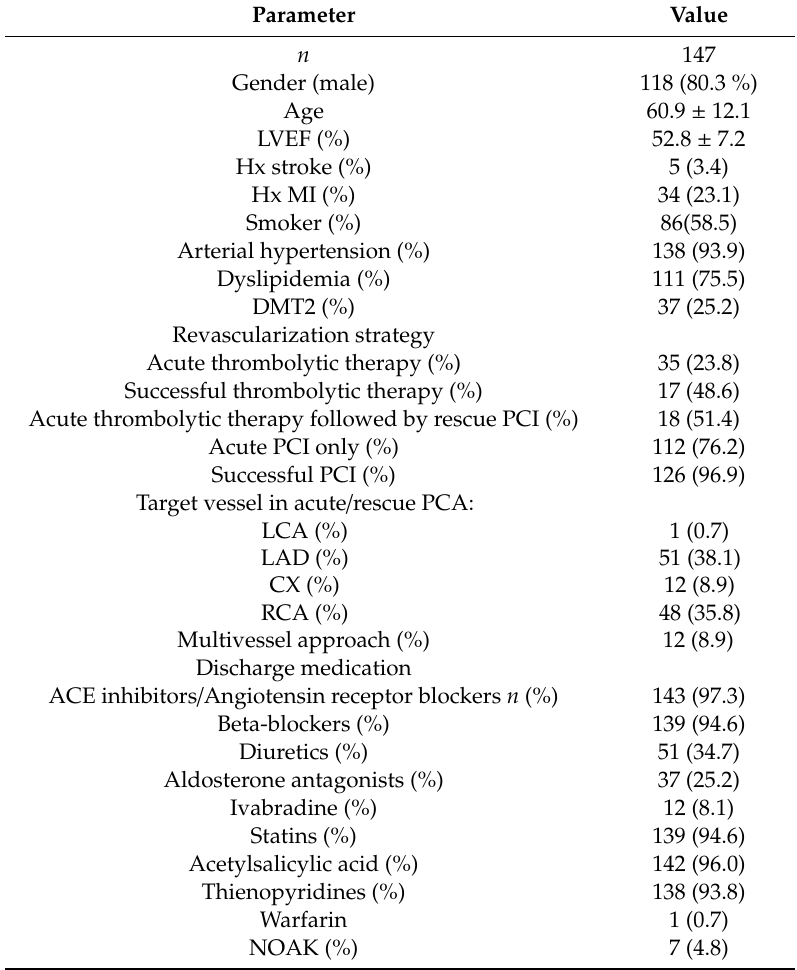
Table 1. Characteristics of the study